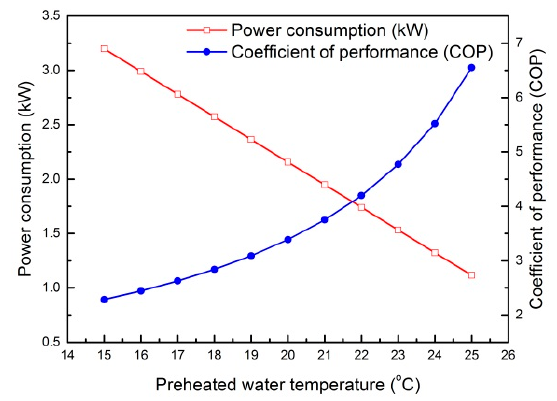
Figure 11. Influence of preheated water temperature on power consumption and COP.